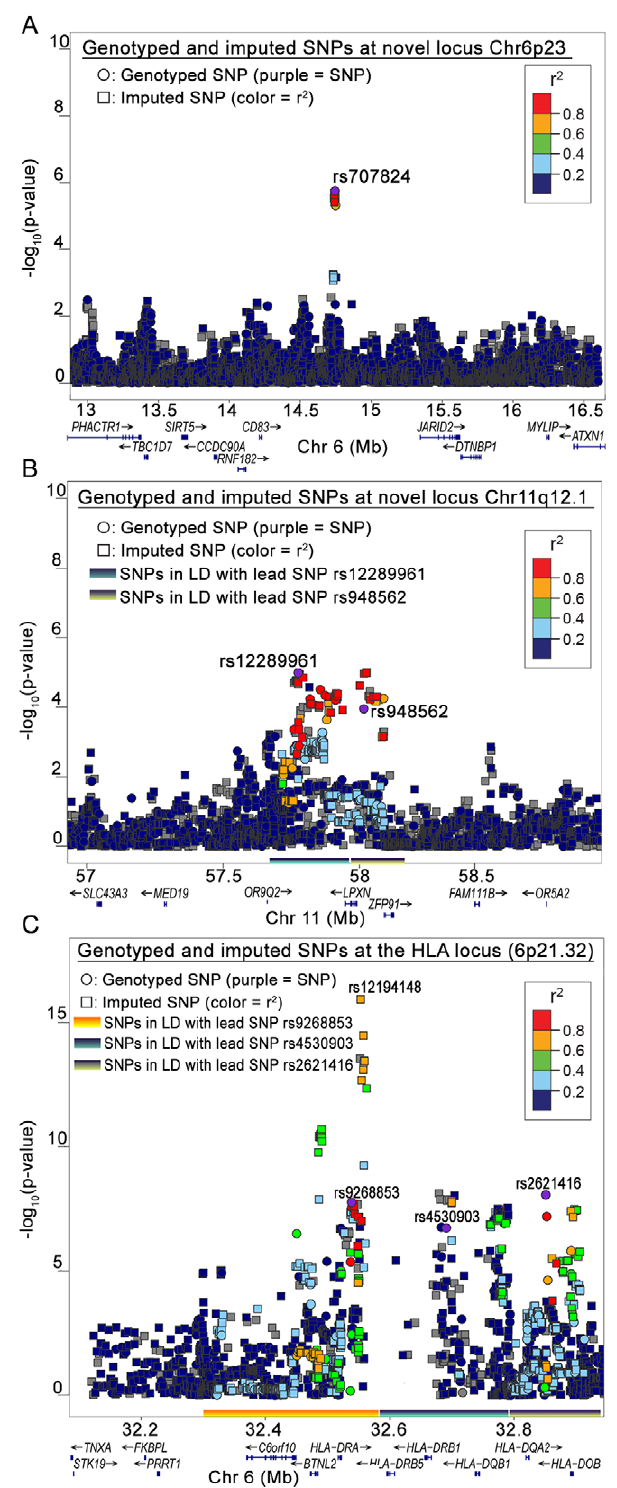
Figure 3. Regional plots from stage-1 GWAS. (A) Chr6p23, (B) Chr11q12.1 and (C) Chr 6p21.32. The regions corresponding to LD between lead SNPs and other SNPs are marked on the X axis of the plot.